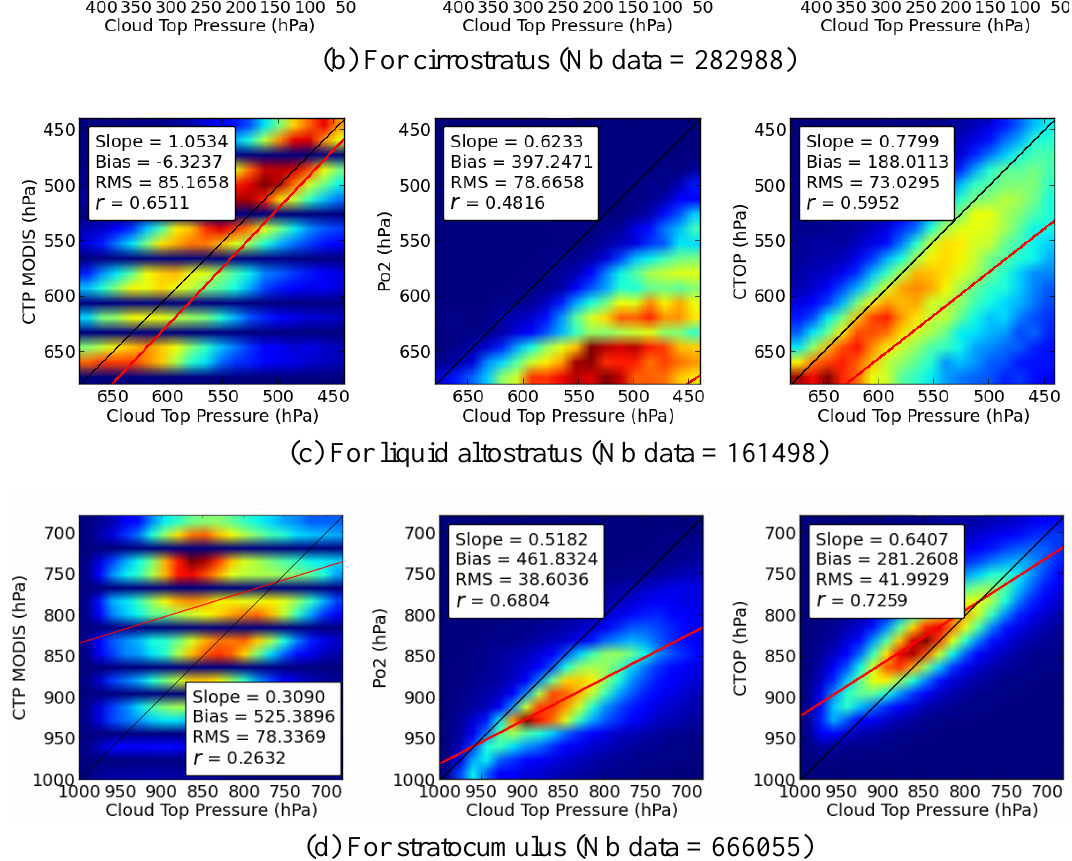
, middle panels) and 2